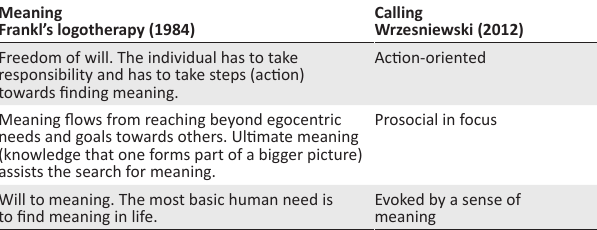
Calling Wrzesniewski (2012)